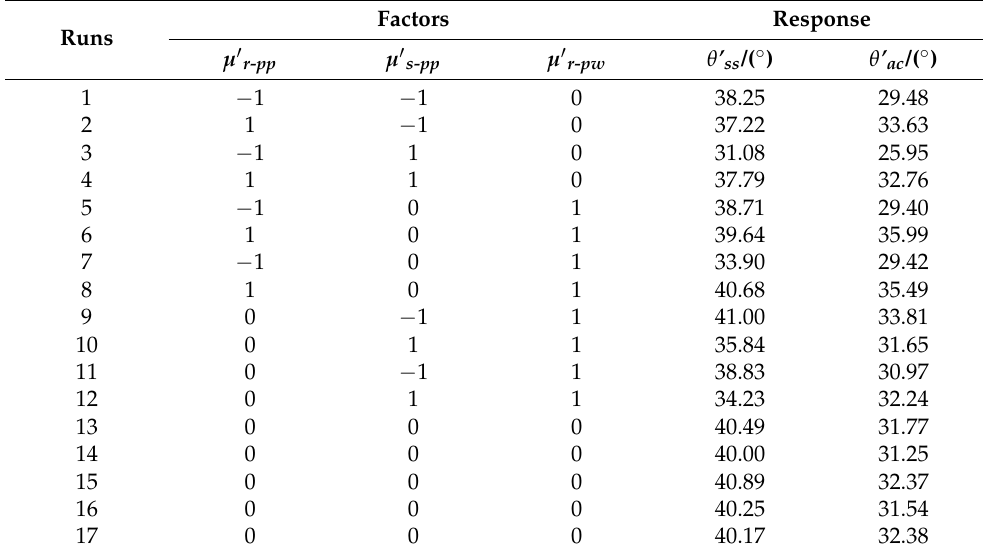
Table 5. Experimental scheme and response results based on the BBD